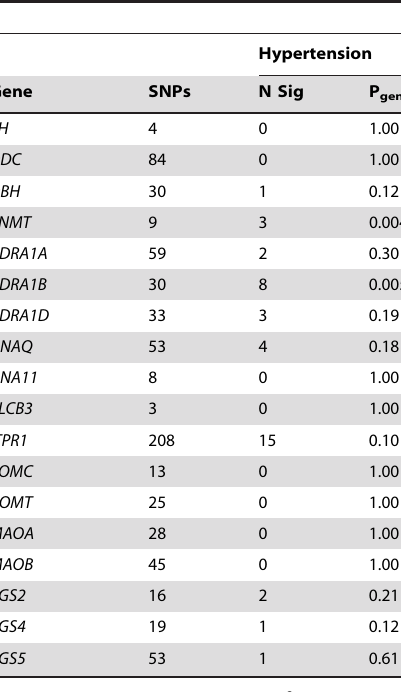
Table 3. Genes in the ADRA1 Pathway.